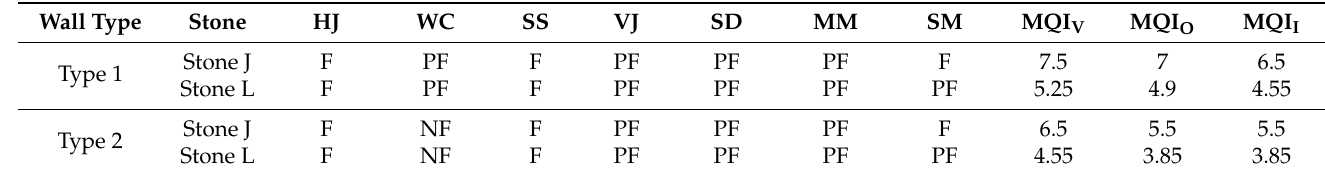
Table 3. The building stone coding according to their origin.